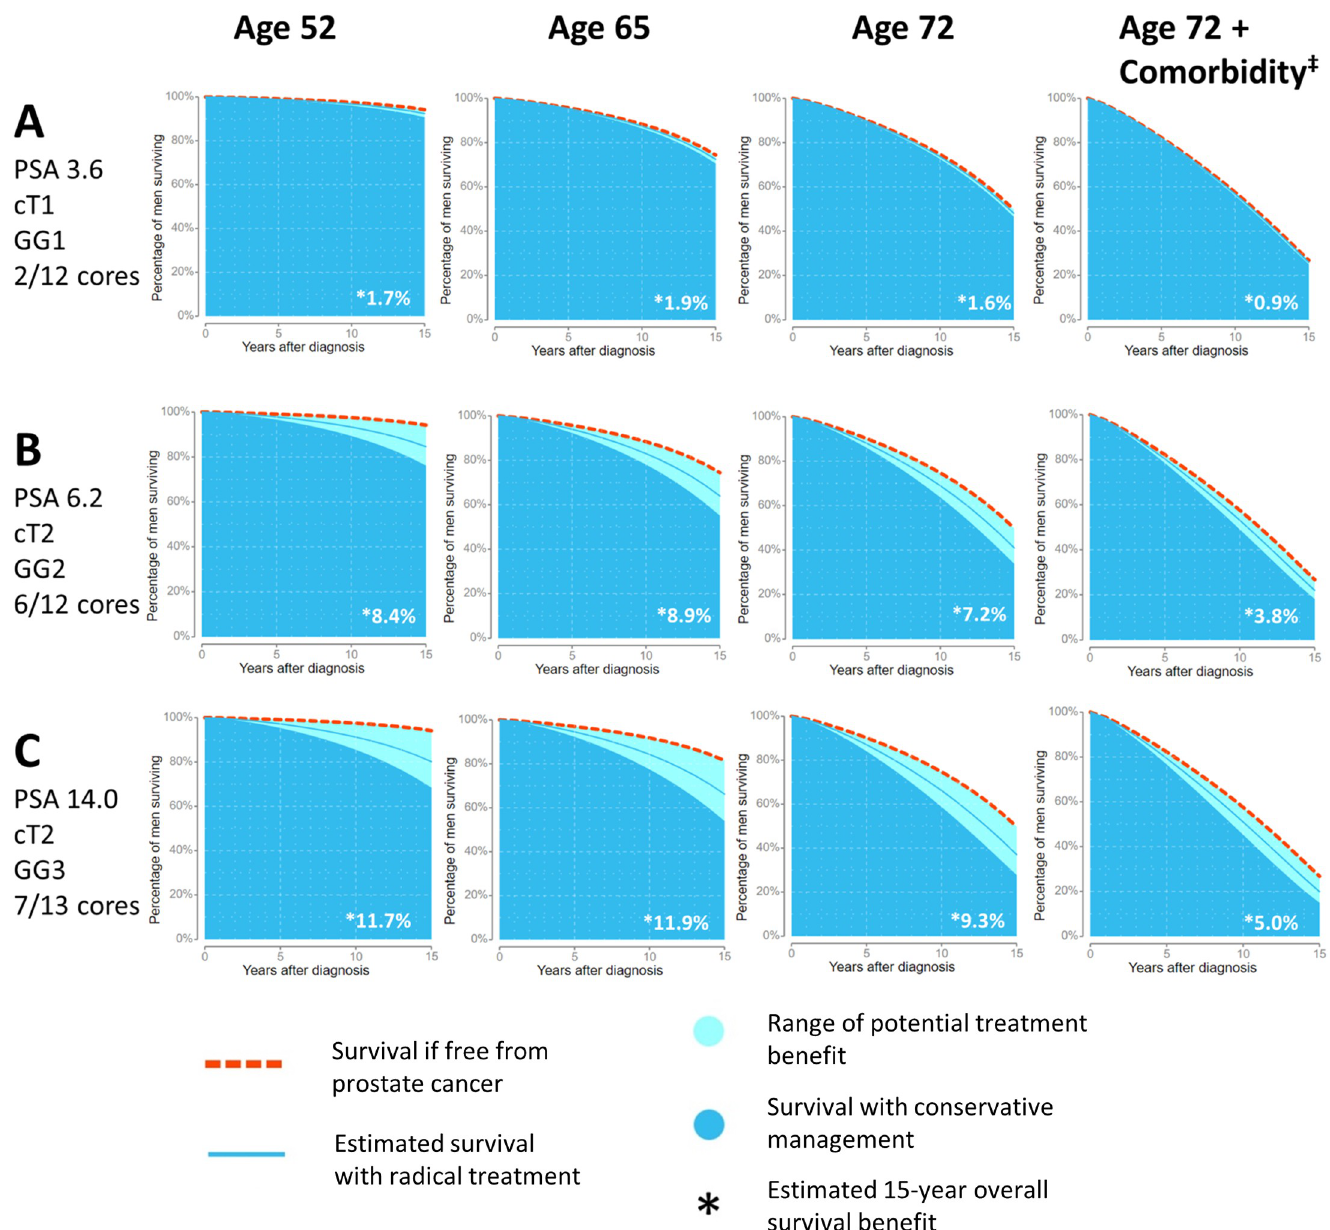
Fig 3. Example model outputs using 15-year overall survival curves for three hypothetical vignettes, A, B, and C. Only age and comorbidity status have been changed between each column to demonstrate the reduction in benefit from radical treatment when competing risk increases. ‡Comorbidity refers to a patient with Charlson score of 1 or more who has been admitted to hospital in the 2 years prior to PCa diagnosis. cT, clinical tumour stage; GG, histological grade group; PCa, prostate cancer; PSA, prostate-specific antigen.